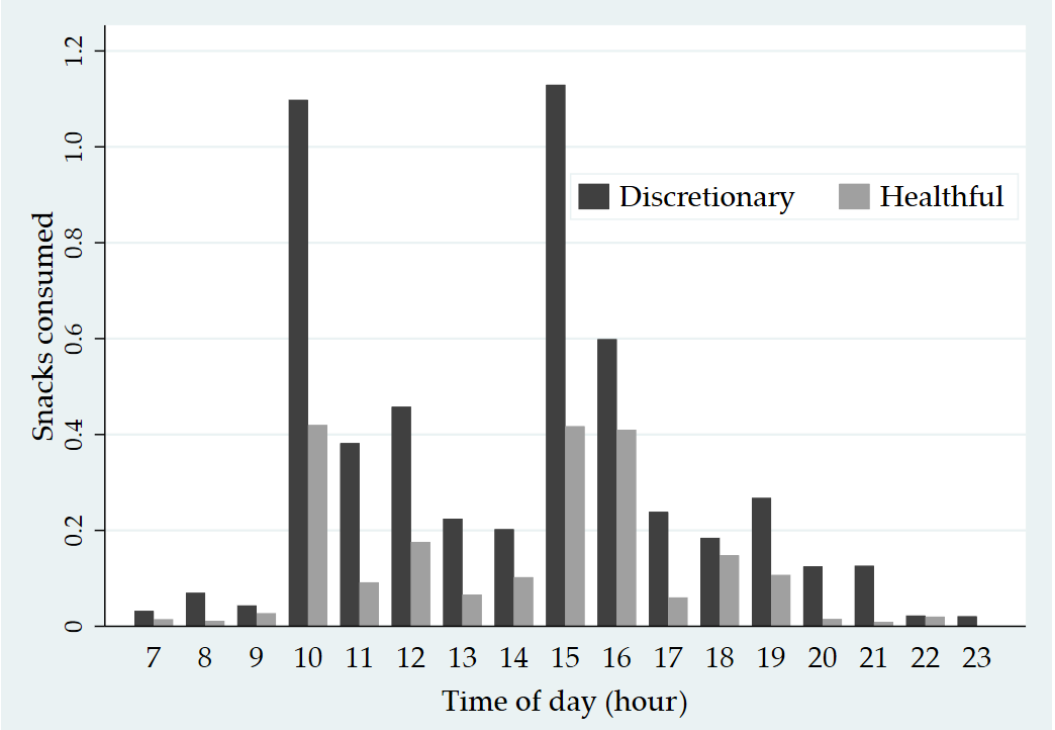
Figure 3. Rates of discretionary and healthful snacking by the hour.